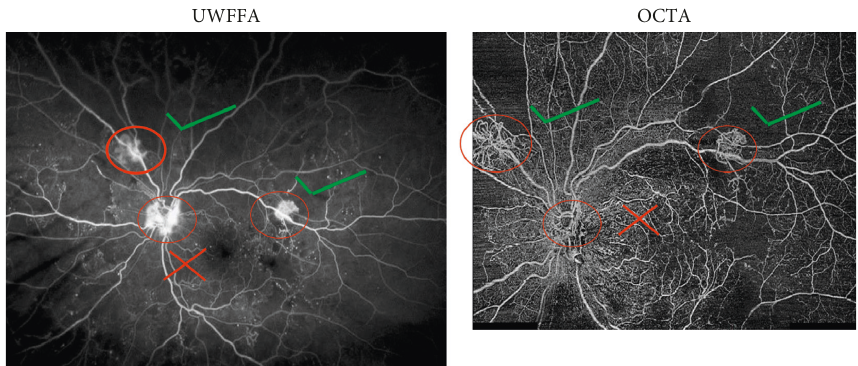
Figure 1: Example of a retinal neovascularization (NV) site that showed leakage on the ultra-widefield fluorescein angiography (UWF-FA) scan (left) but was missed by one of the graders on the en face optical coherence tomography angiography (OCTA) scan (right). A total of three NV sites are present (red ovals); the two with the green check-mark were identified on both scans, while the site with the red “X” was not seen on en face OCTA images.